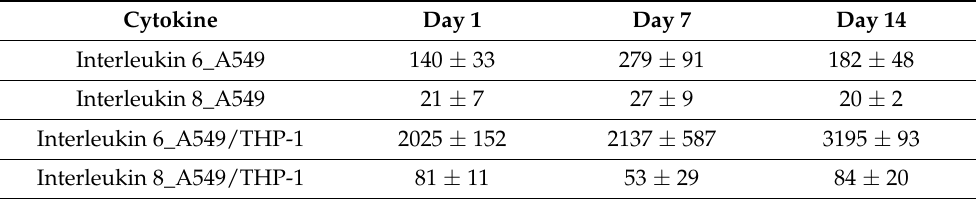
Table 6. Time-dependent changes in interleukin 6 secretion (pg/mL) and interleukin 8 (ng/mL) secre- tion by A549 mono and A549/THP-1 coculture upon stimulation with 100 ng/mL lipopolysaccharide (LPS). Since cytokine levels of untreated cultures were zero or below zero, normalization to % of control could not be